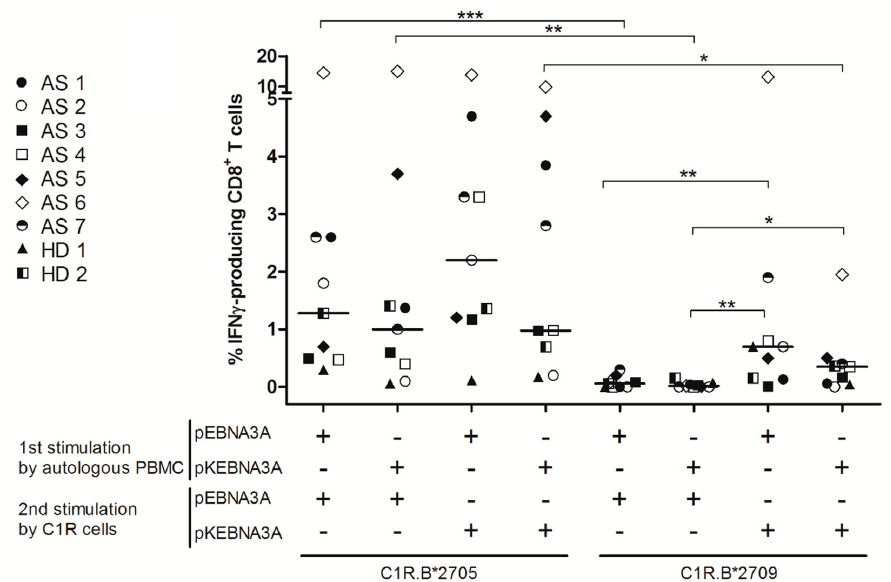
Figure 2. Usage of pEBNA3A in the first stimulation followed by pKEBNA3A as boost leads to the most effective CD8+ T response. IFN γ production by CD8+ T cells was assessed in nine B*2705 positive carriers (seven patients with AS indicated as AS and two healthy subjects indicated as HD). PBMCs were first stimulated with pEBNA3A or pKEBNA3A (12 days) and then re-stimulated with C1R expressing B*2705 or B*2709 molecules, pre-pulsed with the 9-mer or the N-extended version. The percentages of IFN γ -producing CD8 + T cells were compared by Mann Whitney test; *** p value <